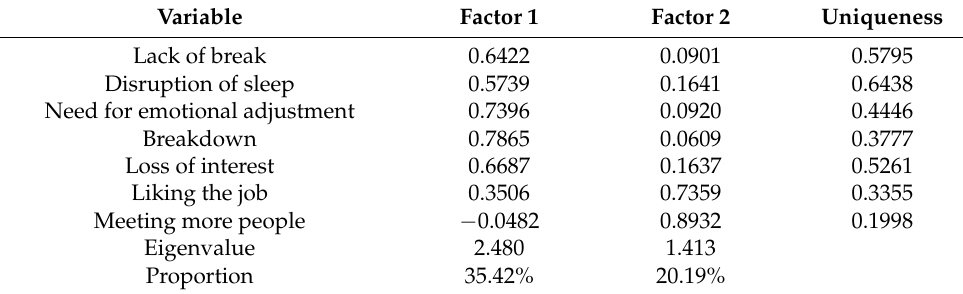
Table 5. Component matrix of burnout (after rotation).